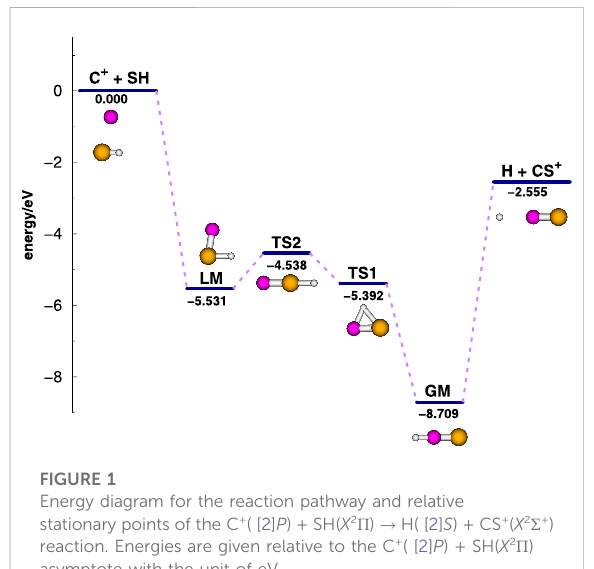
FIGURE 1 Energy diagram for the reaction pathway and relative stationary points of the C + ( [2] P ) + SH( X 2 Π ) → H( [2] S ) + CS + ( X 2 Σ + ) reaction. Energies are given relative to the C + ( [2] P ) + SH( X 2 Π ) asymptote with the unit of